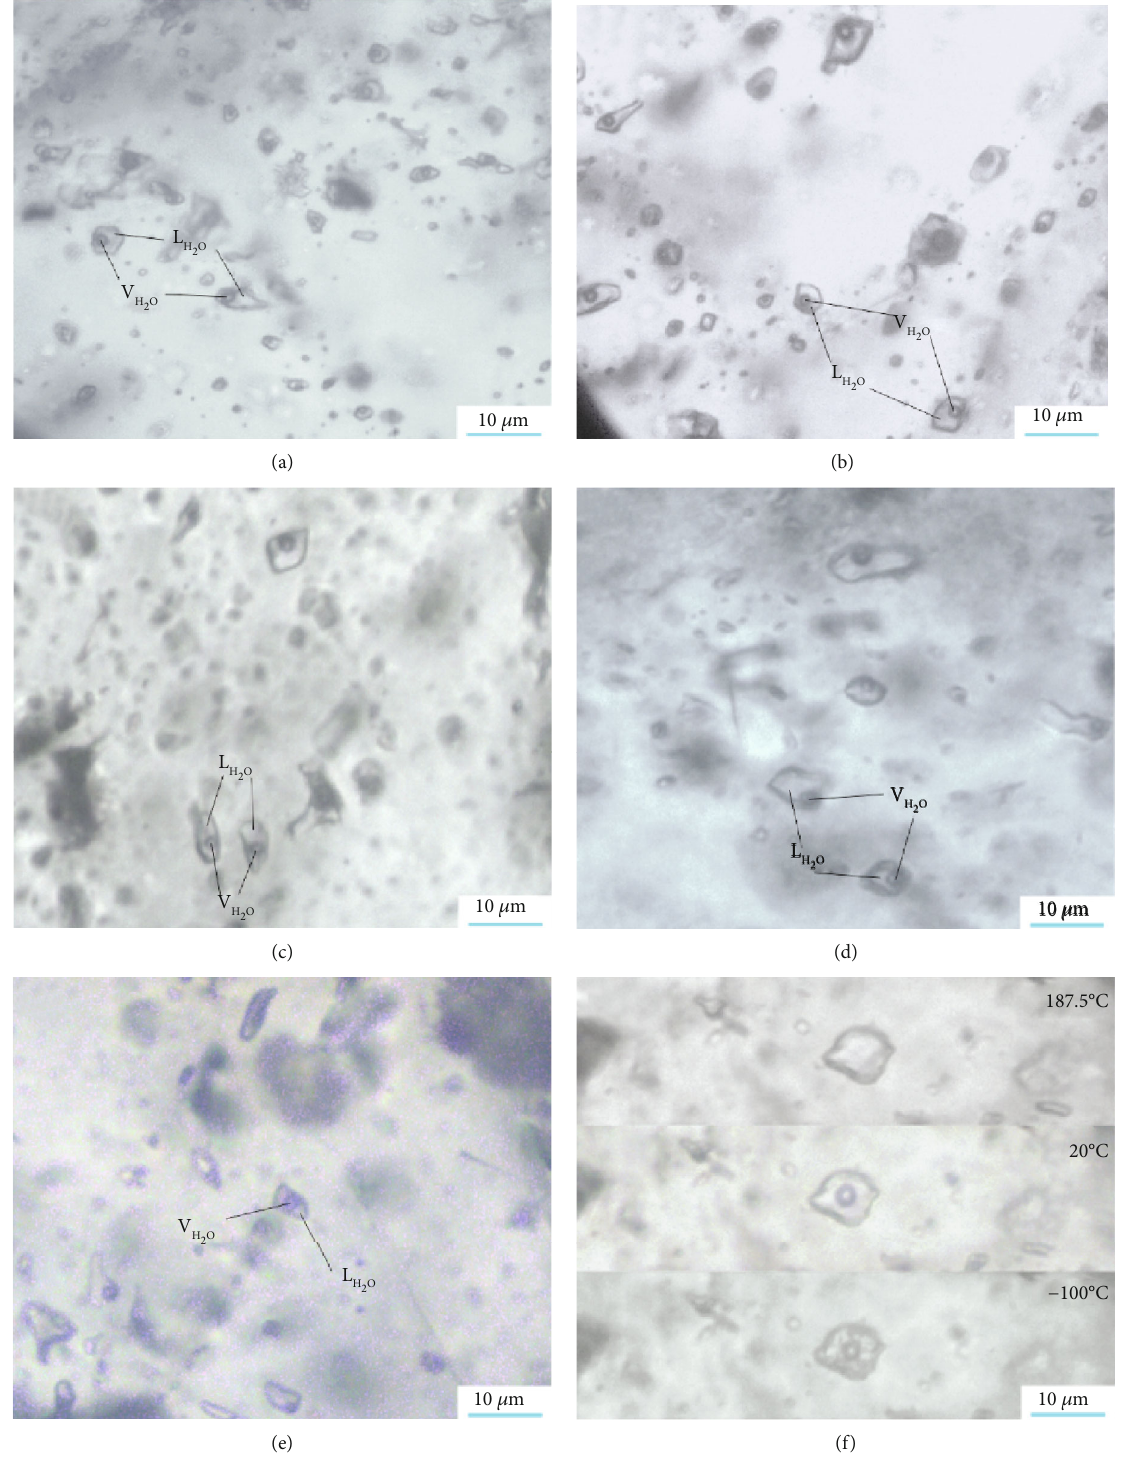
Figure 8: Photomicrographs of representative fl uid inclusions in quartz crystals from the Tieling Cu-Mo deposit: (a) liquid-rich inclusions in quartz of stage II; (b) liquid-rich inclusions in quartz of stage II; (c) liquid-rich inclusions in quartz of stage II; (d) liquid-rich inclusions in quartz of stage II; (e) liquid-rich inclusions in quartz of stage III; and (f) morphology of liquid-rich inclusions in quartz at di ff erent temperatures. L : liquid-phase H O; V : vapor-phase H H2O 2 H2O 2